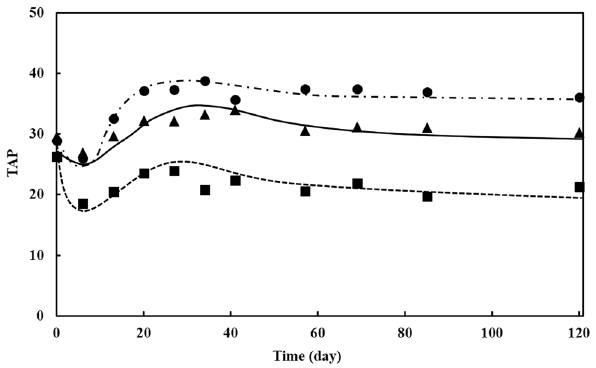
Figure 1: Changes of relative TAP OH ( ● ) , PF ( ▲ ) , and TAP DPPH ( ■ ) [ % ] values during fermentation of